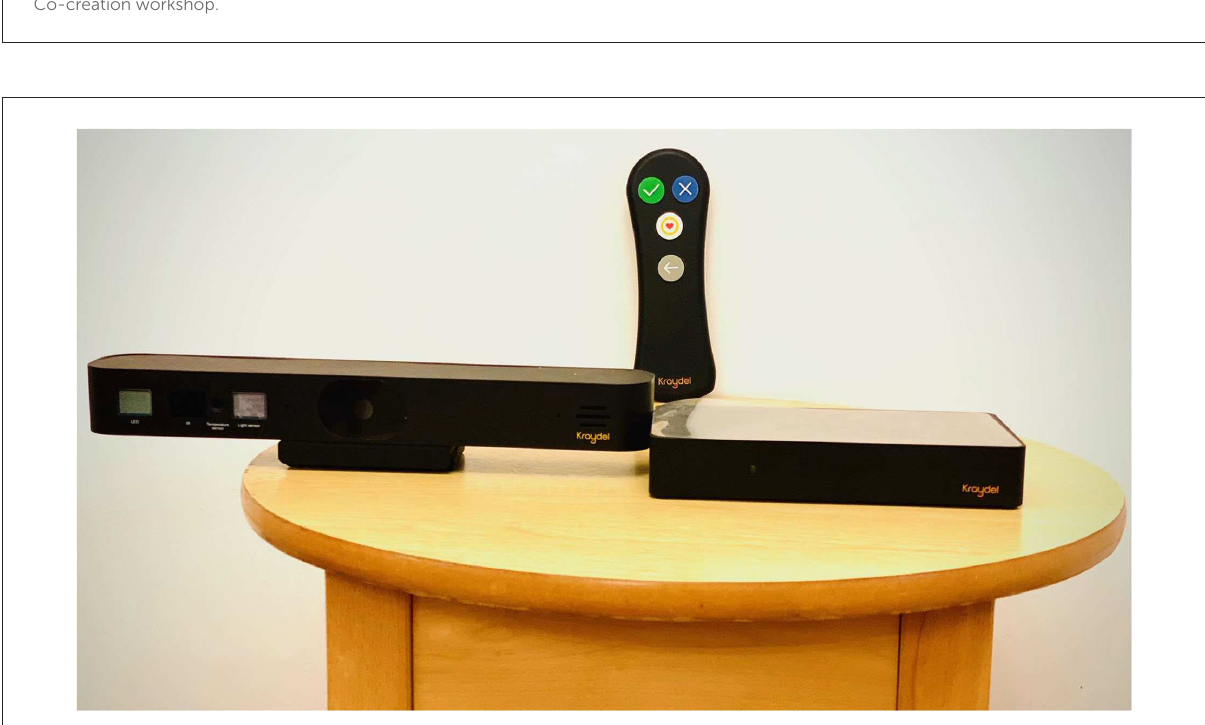
FIGURE8 Kraydel Konnect updated